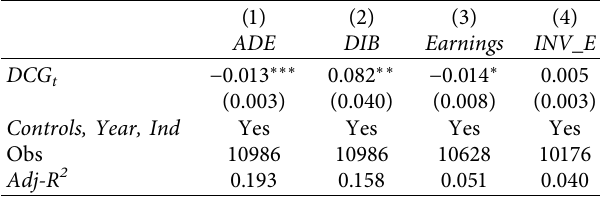
Table 5: Analysis of mechanism: agency problems.